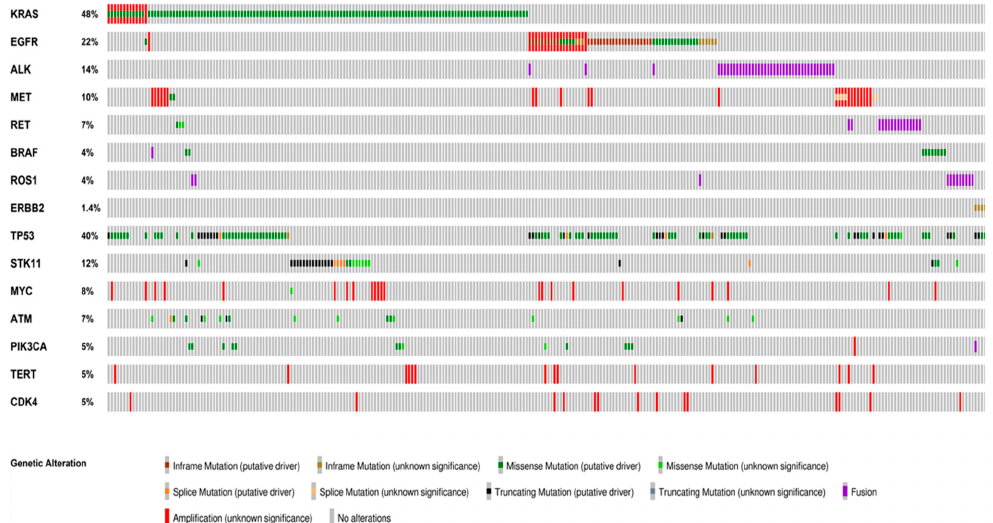
Figure 1. Distribution and co-occurrence of actionable and concurrent gene alterations. Oncoprint plots showing the distribution of actionable gene alterations, concurrent actionable alterations and other co-occuring gene alterations identified in more than 5% of the cases. The type of alteration is color-coded according to the legend below. Co-occurrences of actionable gene alterations included MET amplification, KRAS and EGFR mutations. The most frequent concurrent alterations were TP53 and STK11 mutations. Oncoprinter tool—cBioportal (https://www.cbioportal.org/oncoprinter, accessed on 10 March 2021). Cancers 2021 , 13 , x